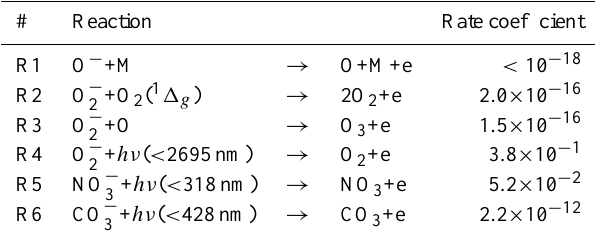
Table 1. Most important electron-detachment reactions from the SIC model. Sources of the rate coefficients are listed in Turunen et al. (1996). Units are m 3 s − 1 for R1–R3 and s − 1 for the other